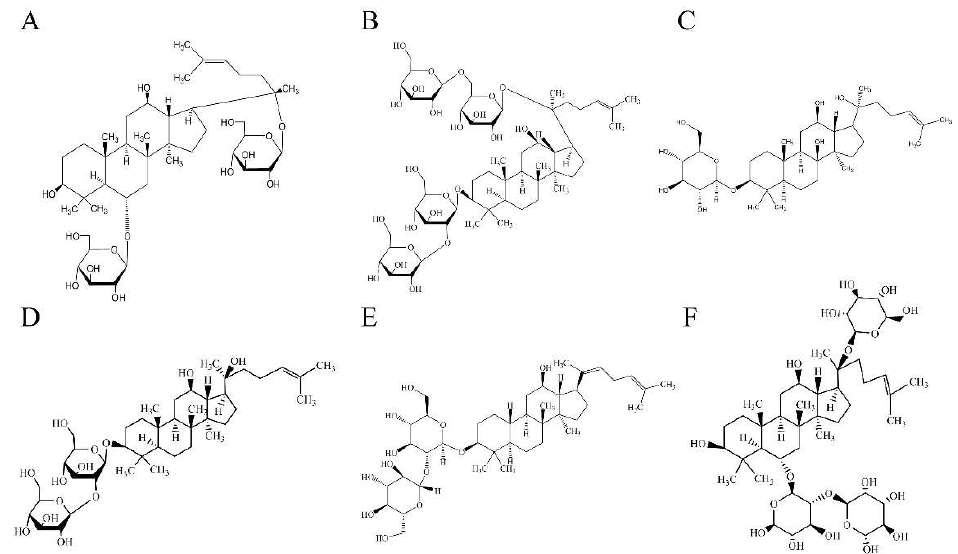
Figure 1. The chemical structures of ginsenosides. Ginsenoside Rg1 ( A ), ginsenoside Rb1 ( B ), ginsenoside Rh2 ( C ), ginsenoside Rg3 ( D ), ginsenoside Rg5 ( E ) and ginsenoside Re ( F ).